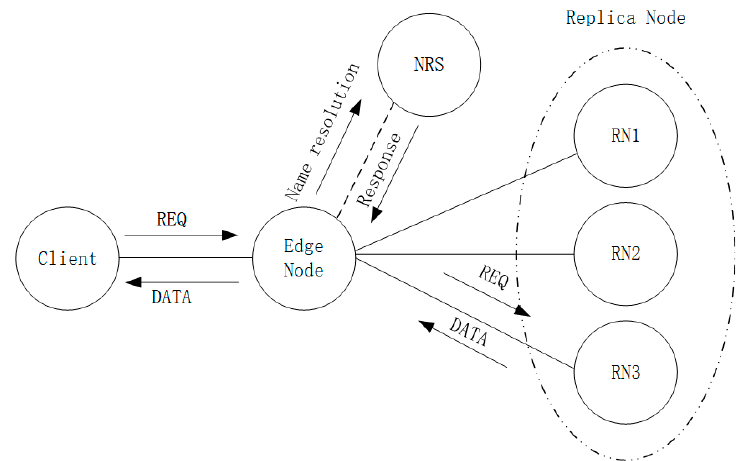
Figure 1. Diagram of NDC transmission